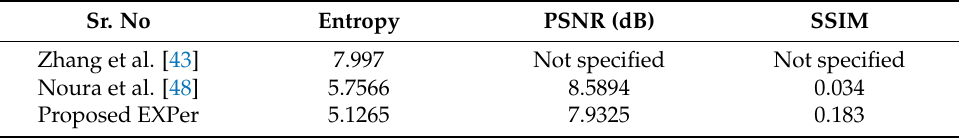
Table 8. Comparison of average PSNR, SSIM and entropy with that of other lightweight ciphers. Sr.